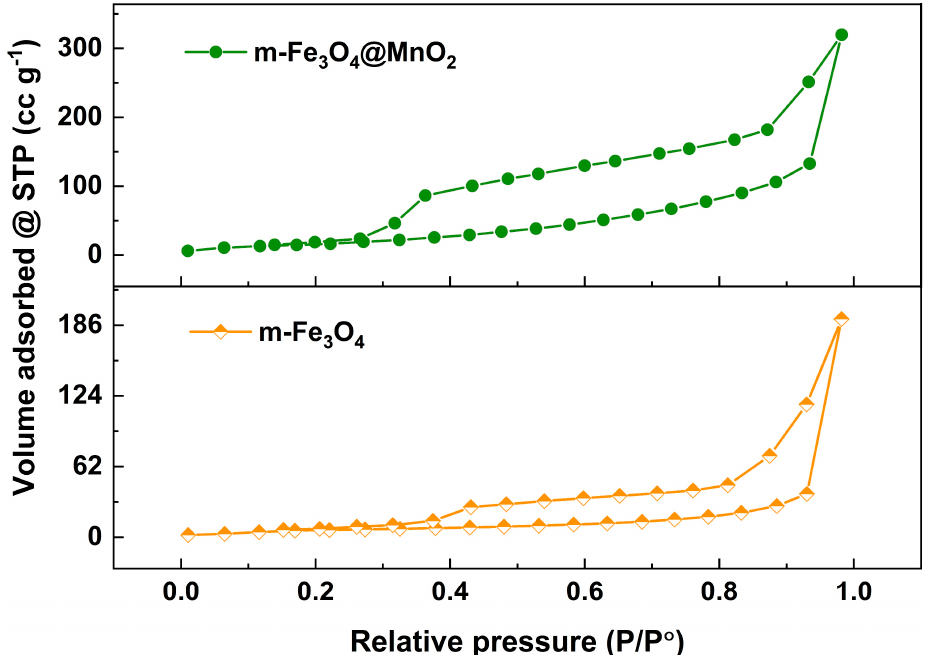
Figure 5. BET results of m − Fe 3 O 4 and m − Fe 3 O 4 @MnO 2 nanocomposites.